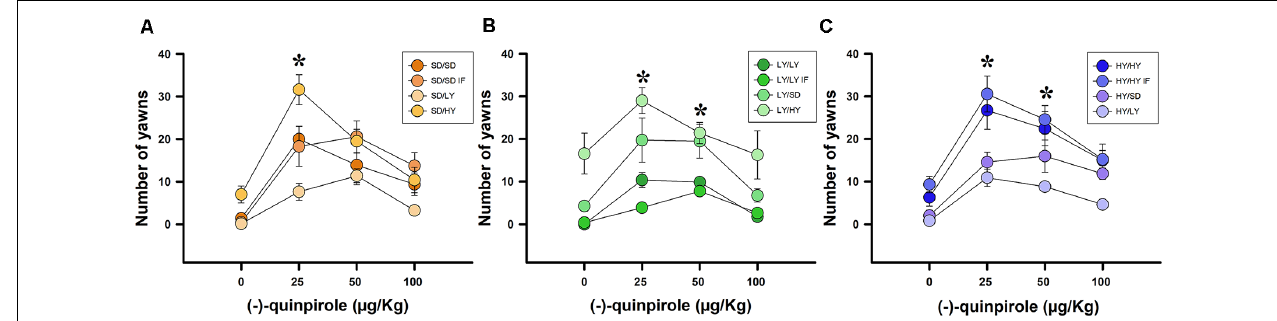
FIGURE 6 | Systemic administration of ( − )-quinpirole increased yawning frequencies, which was dependent on the phenotype of male rats. (A) SD dams that raised HY male rats yawned significant higher with 25 mg/kg of quinpirole with respect to the rest of pairs (SD/HY, * P < 0.05). (B) LY male rats had the lowest yawning frequencies when raised by a dam of their own phenotype, with the highest frequency of yawning occurring when LY dams raised HY male rats (LY/HY; * P < 0.05). (C) HY male rats have the greatest yawning frequencies independent of the phenotype of the dams that raised them. Note that HY/HY IF and HY/HY had significantly higher yawning frequencies with respect to HY/SD and HY/LY (* P < 0.05).